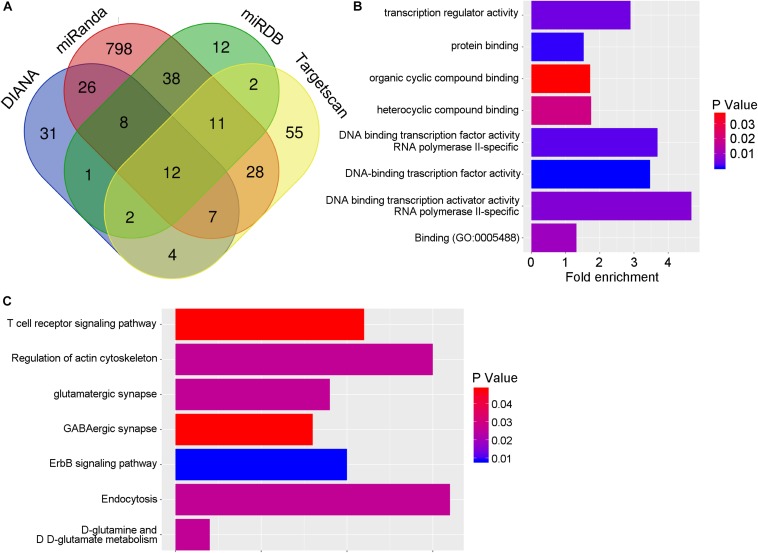
The potential targets of miR-409-5p. (A) The target genes of miR-409-5p were hunted by four prediction databases: miRDB, miRanda, DIANA, and TargetScan. There are 139 target genes intersected in more than two databases by Venn tool. (B,C) Then the biological functions of the intersection genes were analyzed by Gene Ontology, and the KEGG pathways were predicted by DIANA (Table 3). To further narrow down the pool of the potential targets, the 139 target genes were intersected again with upregulated genes (fold changes >1.2) in APP/PS1 mice by a whole transcriptome sequencing previously done in our laboratory.